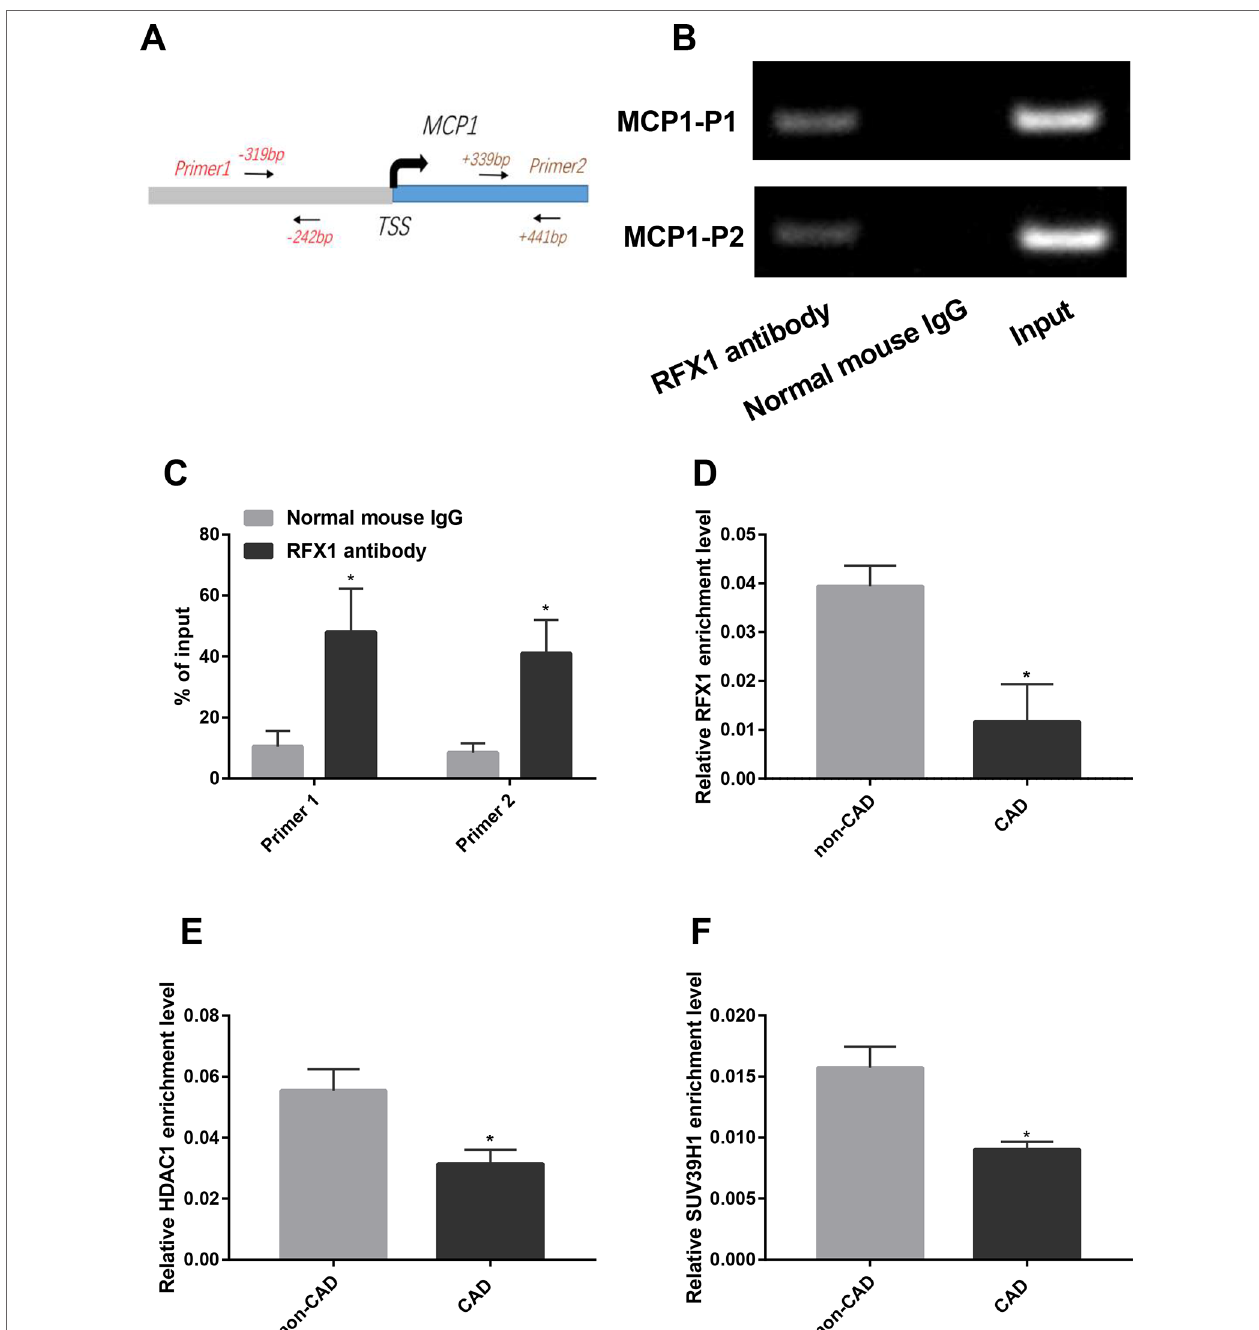
FigURE 2 | RFX1 binds to the promoter region of MCP . (a) A genomic diagram to indicate the genomic locations of primers used in ChIP-PCR . (B) Band diagram of normal PCR amplification of the ChIP product in CD14+ monocyte. (C) Statistical results of band densities indicate the binding of RFX1 to MCP1 promoter determined by ChIP-PCR in CD14+ monocyte. (D – F) Relative recruitment levels of RFX1 (D) , HDAC1 (E) and SUV39H1 (F) in the promoter region of MCP1 were detected by ChIP-qPCR in CD14+ monocytes from CAD and non-CAD patients. All values were the average of at least three biological replicates, and the data shown are mean ± SEM. * P 0.05 relative to the